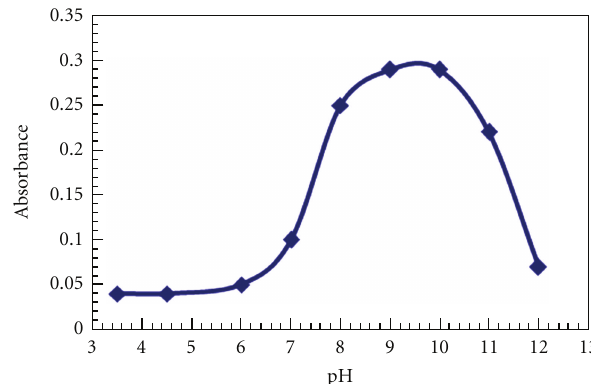
Figure 2: E ff ect of pH on the absorbance of nickel-fruildiome complex.